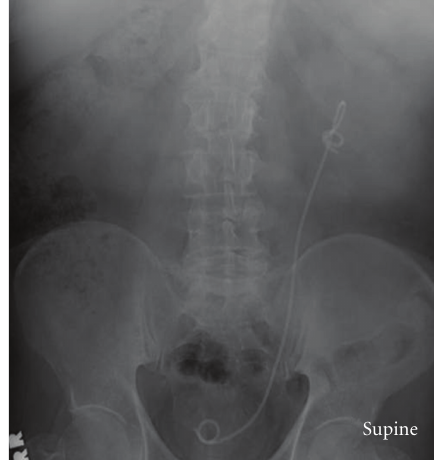
Figure 1: A plain X-Ray film shows the coiled proximal part of the JJ stent with formation of an incomplete knot.